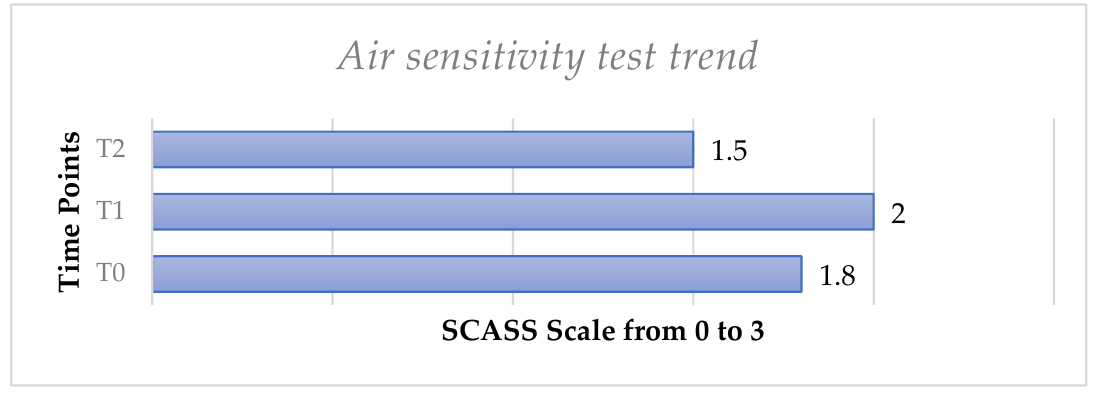
Figure 3. Mean values of air sensitivity test from T0 to T2 for all molar teeth with hypersensitivity considered for each patient.